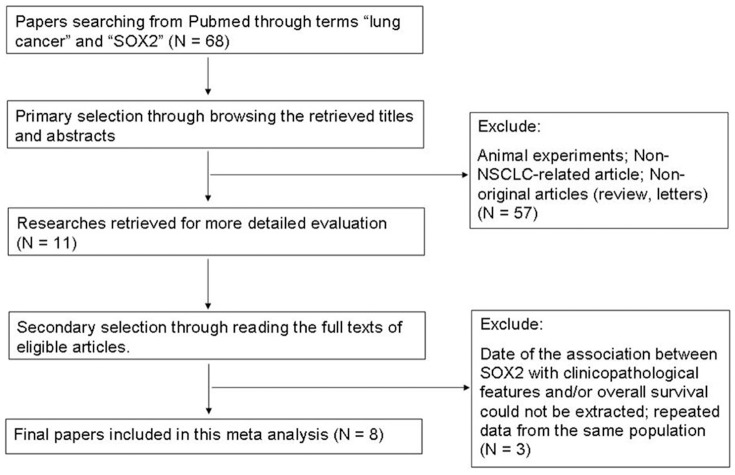
Flow chart for selection of studies for inclusion in this meta-analysis.